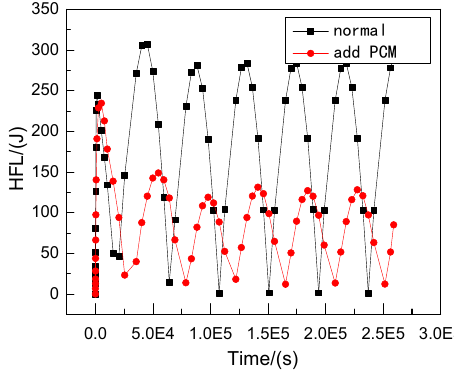
Figure 16. Transient heat transfer heat flux characteristic curve.